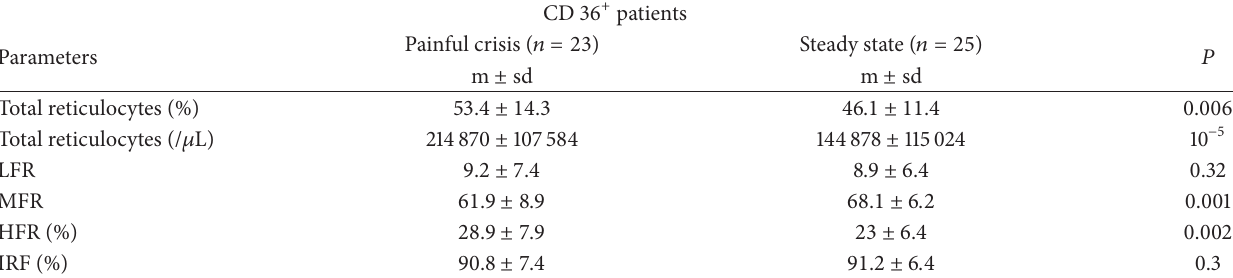
Table 4: Distribution of CD 36 + reticulocytes according to their degree of maturity and the clinical